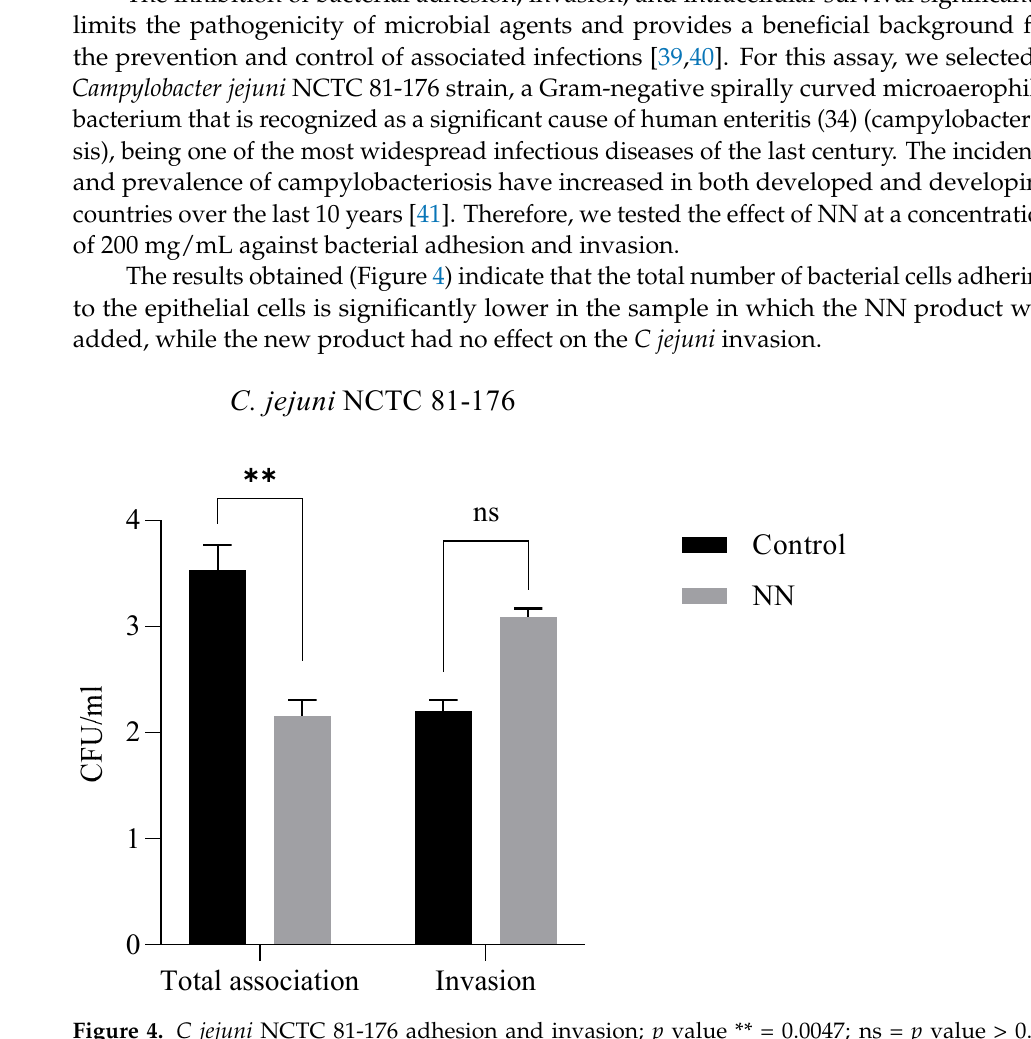
Figure 4. C jejuni NCTC 81-176 adhesion and invasion; p value ** = 0.0047; ns = p value > 0.05 (non-significant statistically).